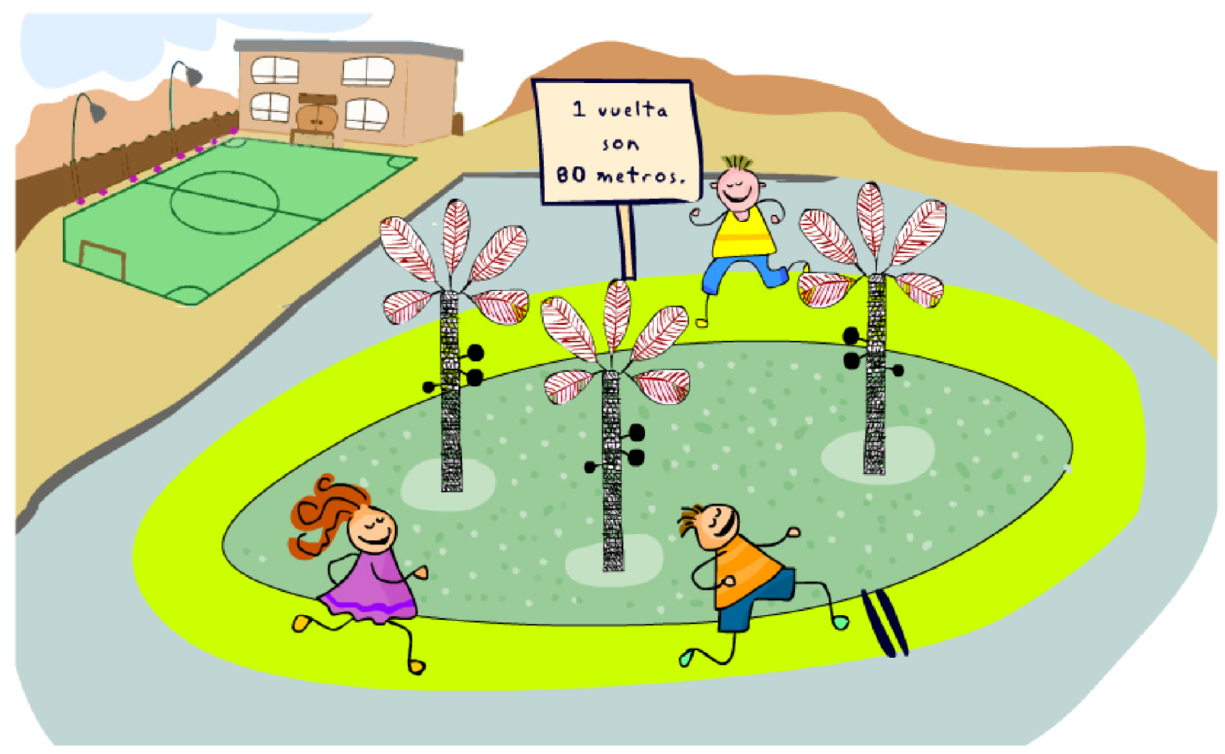
Figure 2. Reagent of problem posing task (The sign reads: One lap is 80 m).